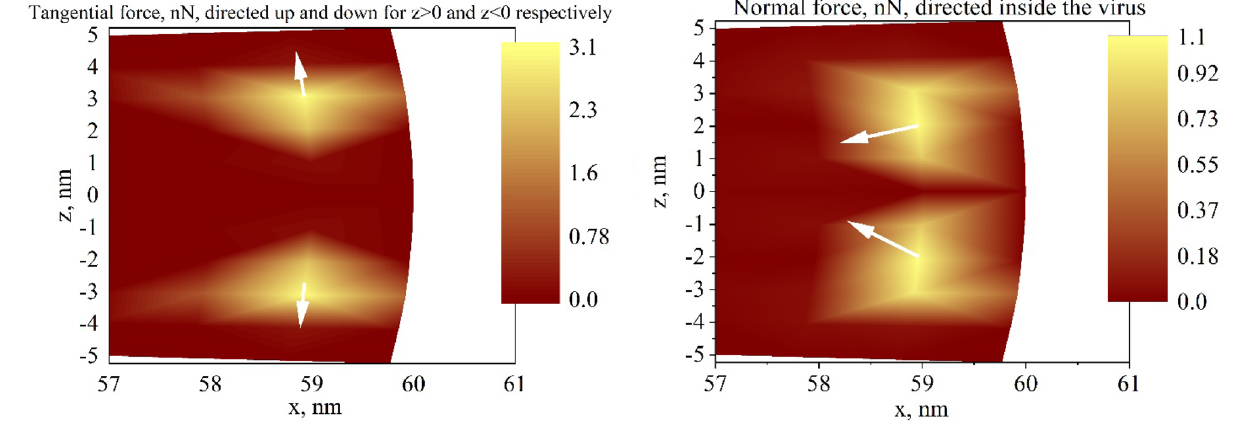
Figure 4. Distribution of tangential (left) and normal force (right) density on the surface of the nanoparticle of 60 nm radius with 10 nm shell ( ε core = 2 , ε shell = 4 ) located close to the nanoparticle of 10 nm radius with ε np = − 10.5 + 1.3 i in the medium with ε m = 1 , (cid:31) = 615 nm . The section at the y = 0